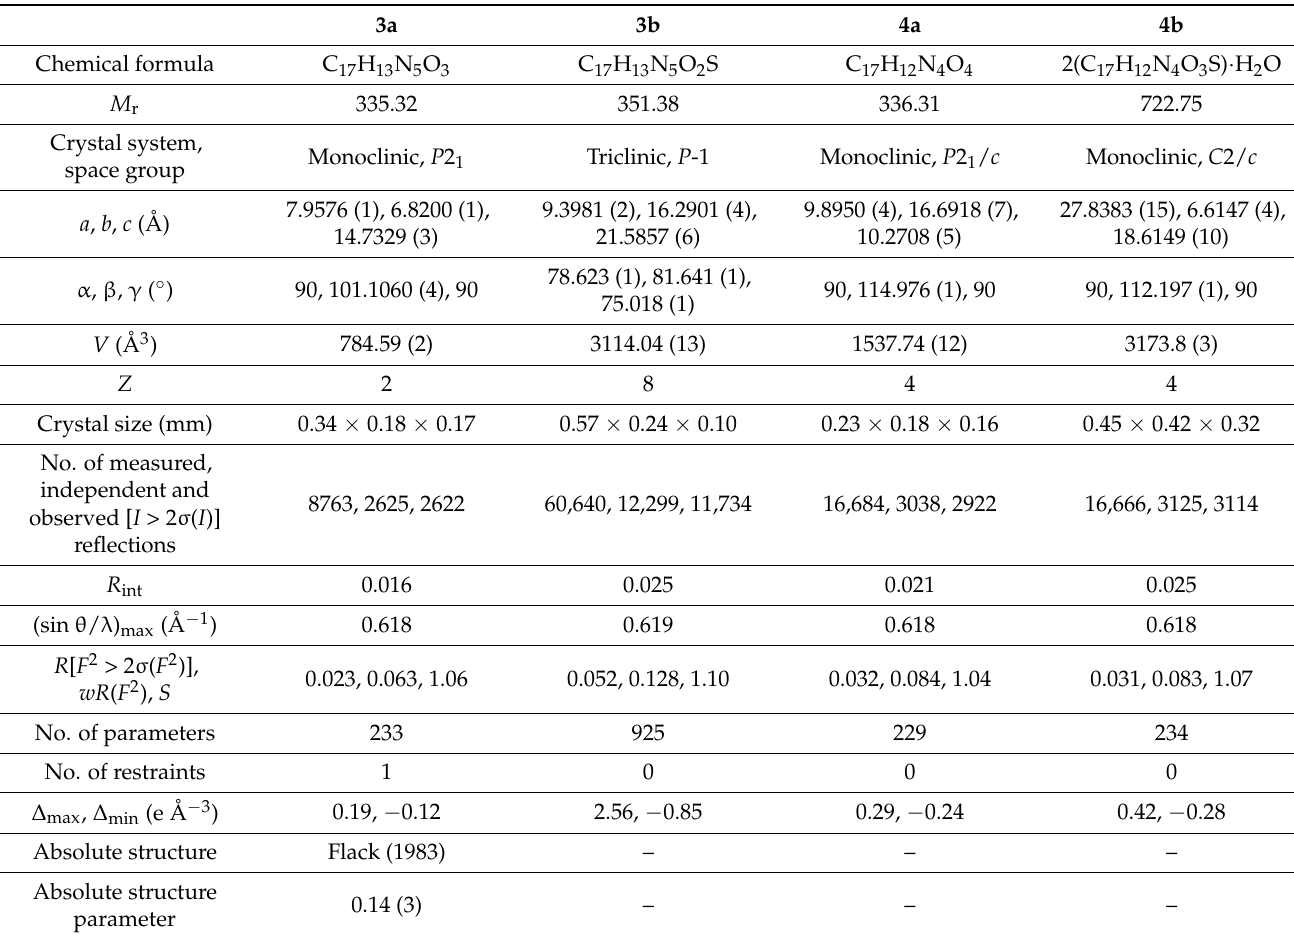
Table 3. Crystal data, data collection and refinement details.